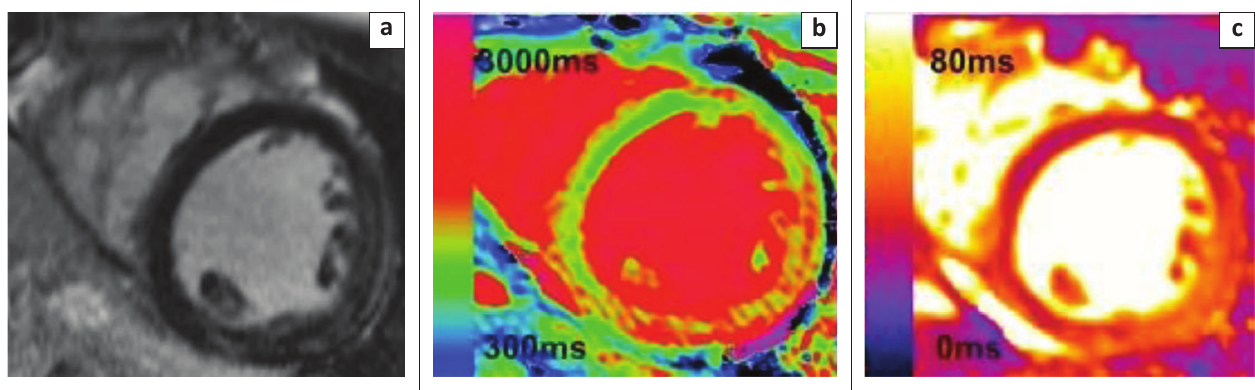
FIGURE 3: LGE (a), T1 (b) and T2 (c) maps in myocarditis. Increased T1 and T2 values in the inferolateral, lateral and anterolateral walls are clearly seen on colour maps but largely missed on LGE imaging (some subtle mid-wall